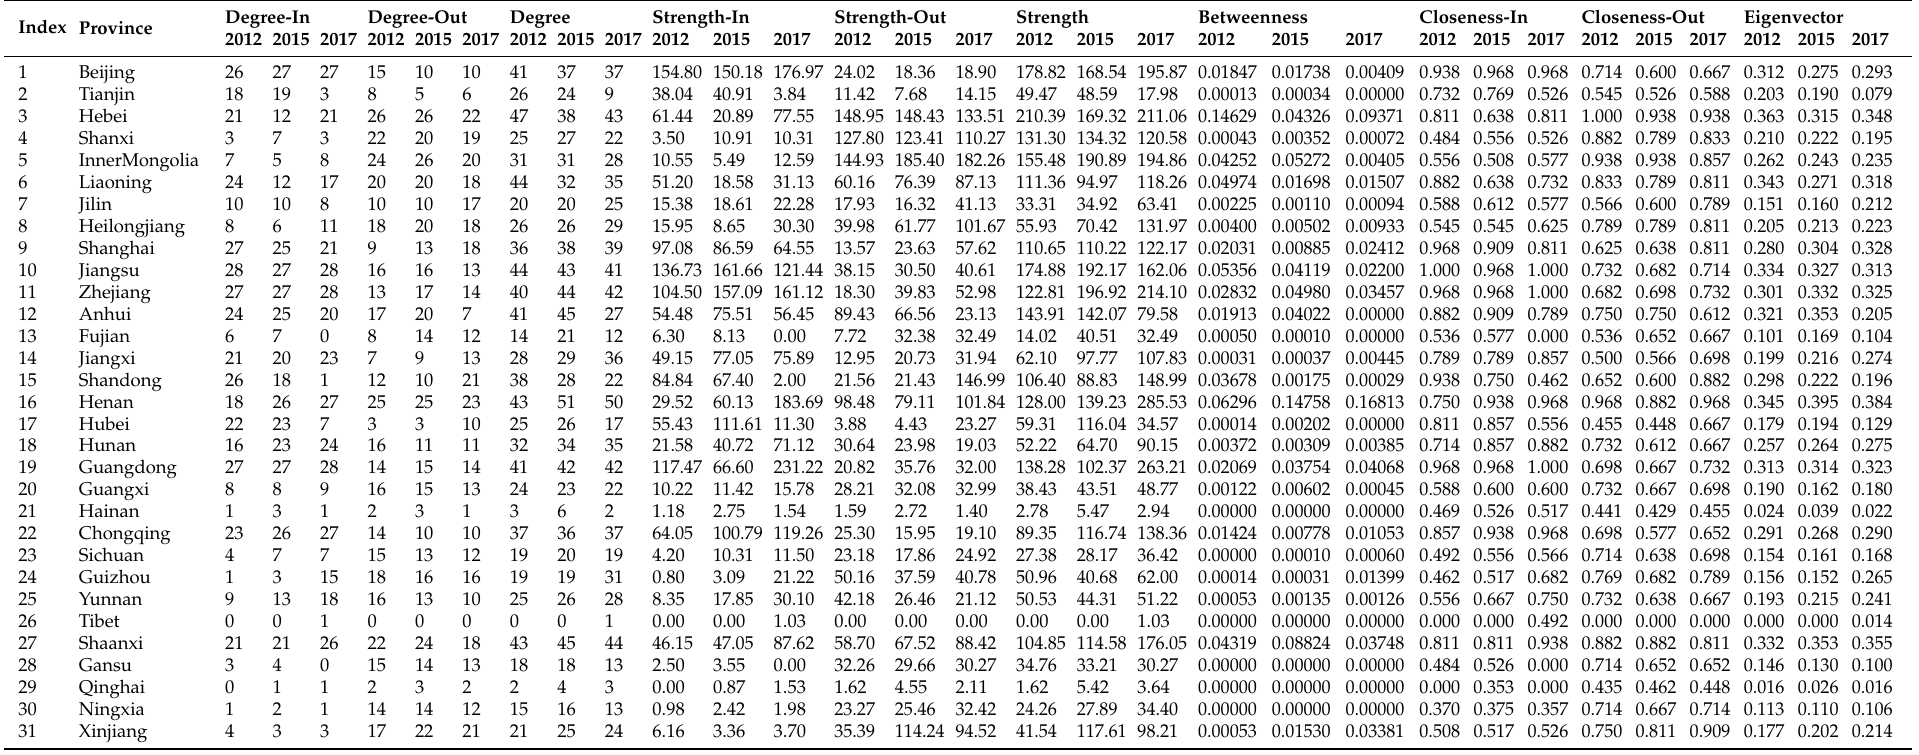
Table A1. Calculation results of the centrality indicators for each